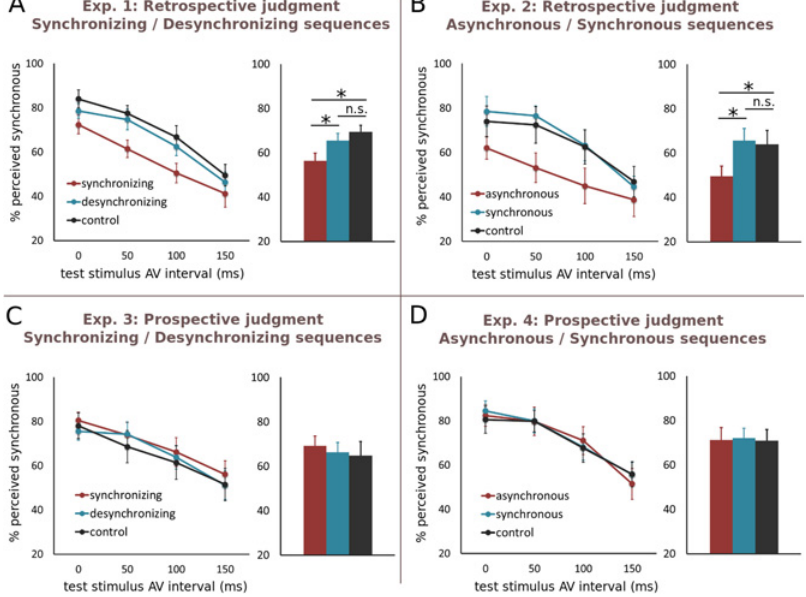
retrospective tasks (A and B). (A) Test stimuli in the Synchronizing condition (red) are perceived significantly less synchronous than stimuli in the Desynchronizing and Control condition (blue and black, respectively). No significant difference was found between the Desynchronizing and Control condition. (B) Test AV stimuli in the Asynchronous condition (red) are perceived as significantly less synchronous than stimuli in the Synchronous (blue) and Control condition (black). No significant difference was found between the Synchronous and the Control condition. In the prospective tasks (C and D), no significant effect of previous context is